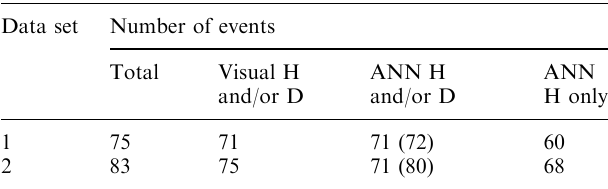
Table 1. Comparisons of the total numbers of Pi2 events with the numbers identified visually and by the ANN for each of the data sets Data set Number of